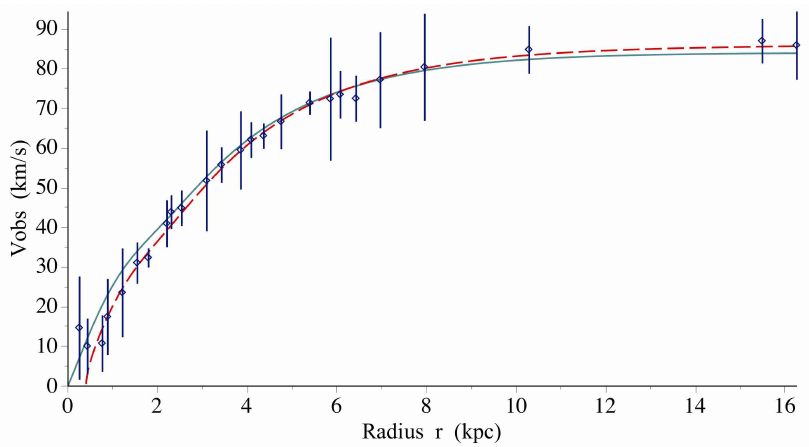
Figure 4. Fits of the rotational velocity curve [22] of galaxy LSBC F583-01 (SPARC database). Green solid curve: ( α , β ) = ( 0.0000,20.8025 ) . Red dashed curve: ( α , β ) = ( − 9.015,22.233 ) .